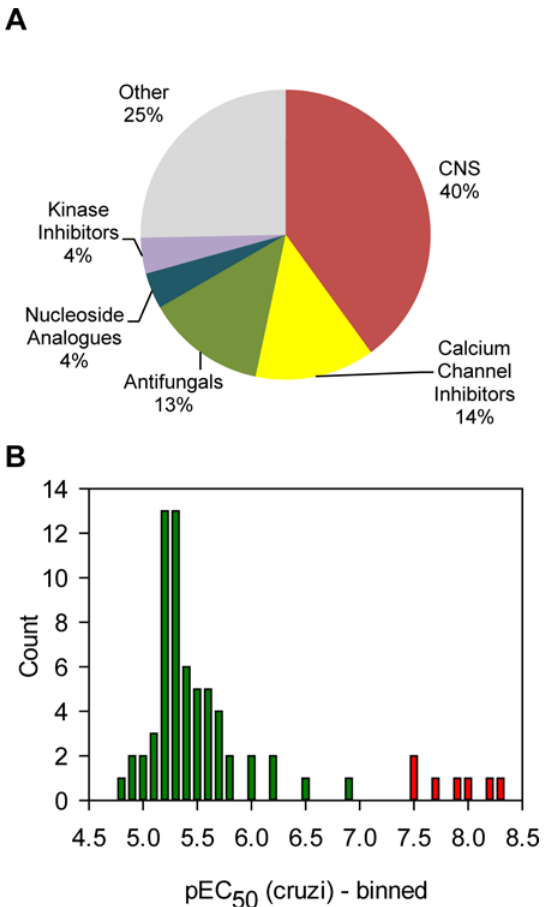
Fig 7. Analysis of the hits. Panel A. All the hits from the 5 μ M screen were annotated with a general pharmaceutical class. The chart shows the frequency for each class. Panel B. The potencies for all the hits were determined and represented as a frequency table. Bars in red represent CYP51 inhibitors, green = all other